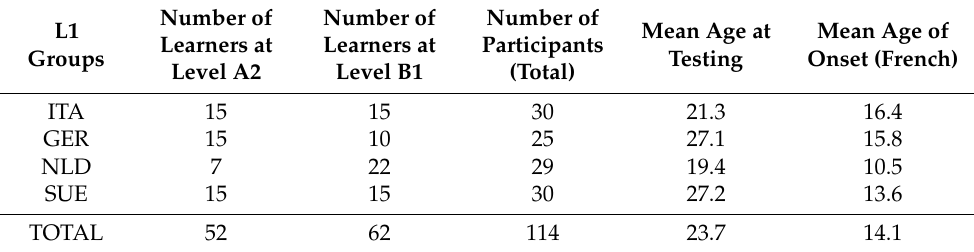
Table 2. General description of the different learner